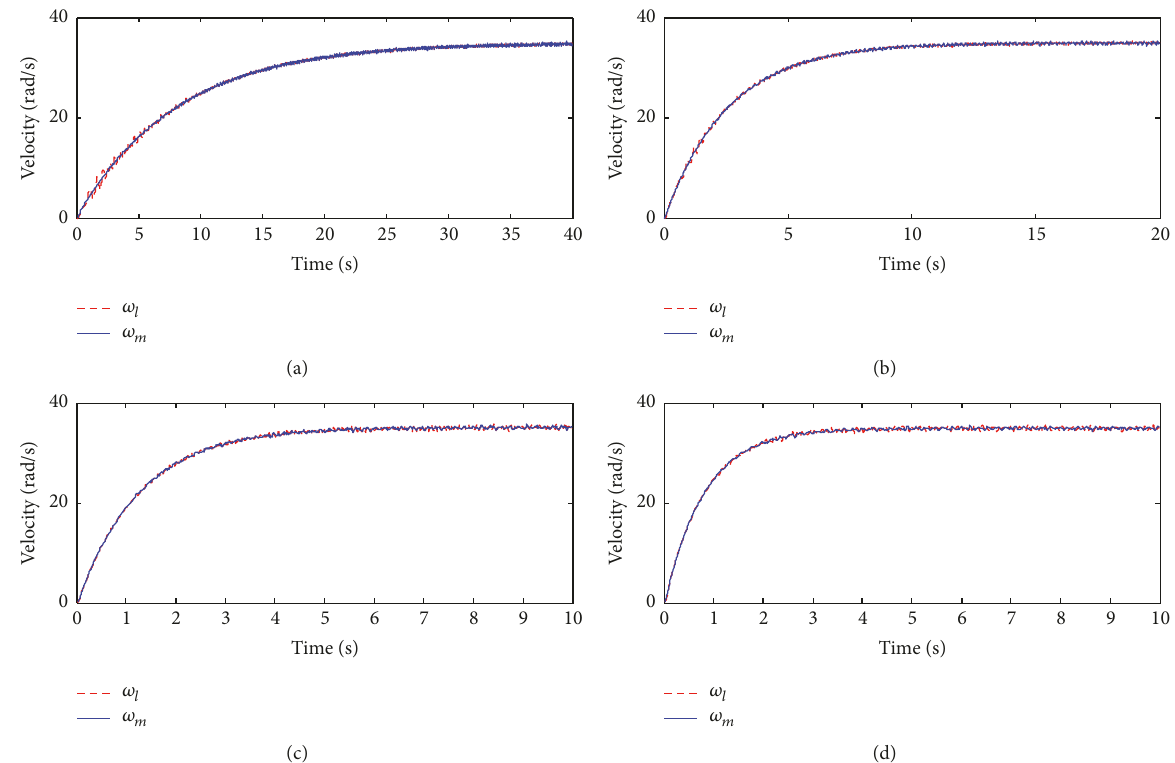
Figure 10: The experimental velocity responses of load side with different springs (𝑞 = 0.290) : (a) spring 1, 𝐾 𝑝 = 0.0093, 𝐾 𝑖 = 1.1943 ; (b) spring 2, 𝐾 𝑝 = 0.0163, 𝐾 𝑖 = 3.7193 ; (c) spring 3, 𝐾 𝑝 = 0.0276 , 𝐾 𝑖 = 4.7772 ; (d) spring 4, 𝐾 𝑝 = 0.0397, 𝐾 𝑖 = 9.922.